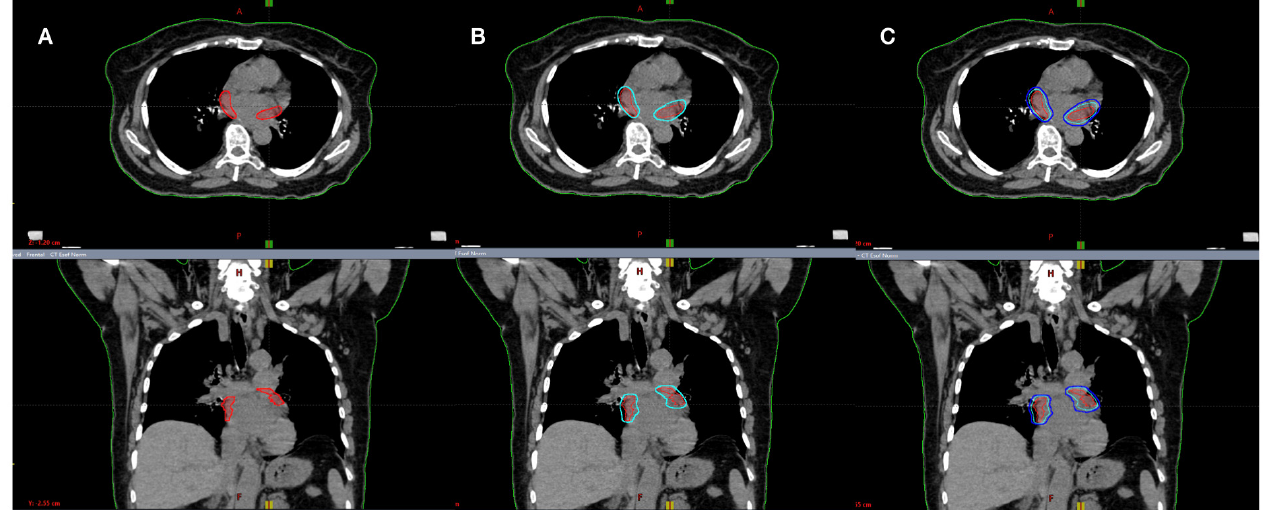
Figure 1. Definition of ( A ) clinical target volume (CTV); ( B ) internal target volume (ITV); ( C ) planning target volume (PTV).